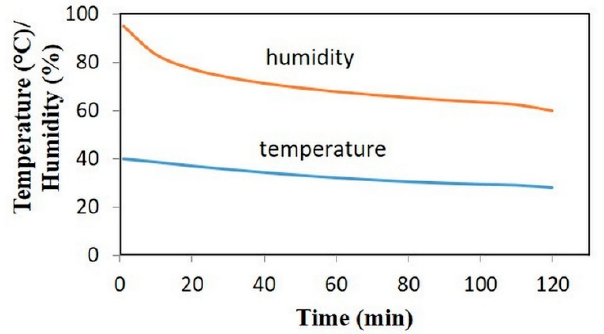
Figure 2. Program set in the humidity chamber simulating the relative humidity and temperature change in the dishwasher during the drying step.